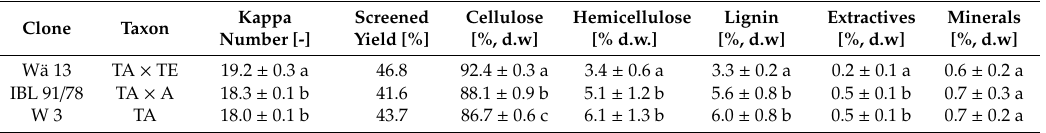
Table 4. Kraft cellulosic pulps and chemical composition of di ff erent clones ± SE, and results of Tukey’s honestly significant di ff erence test. The same lowercase letters indicate statistically homogenous groups at α = 0.05 in Tukey test.